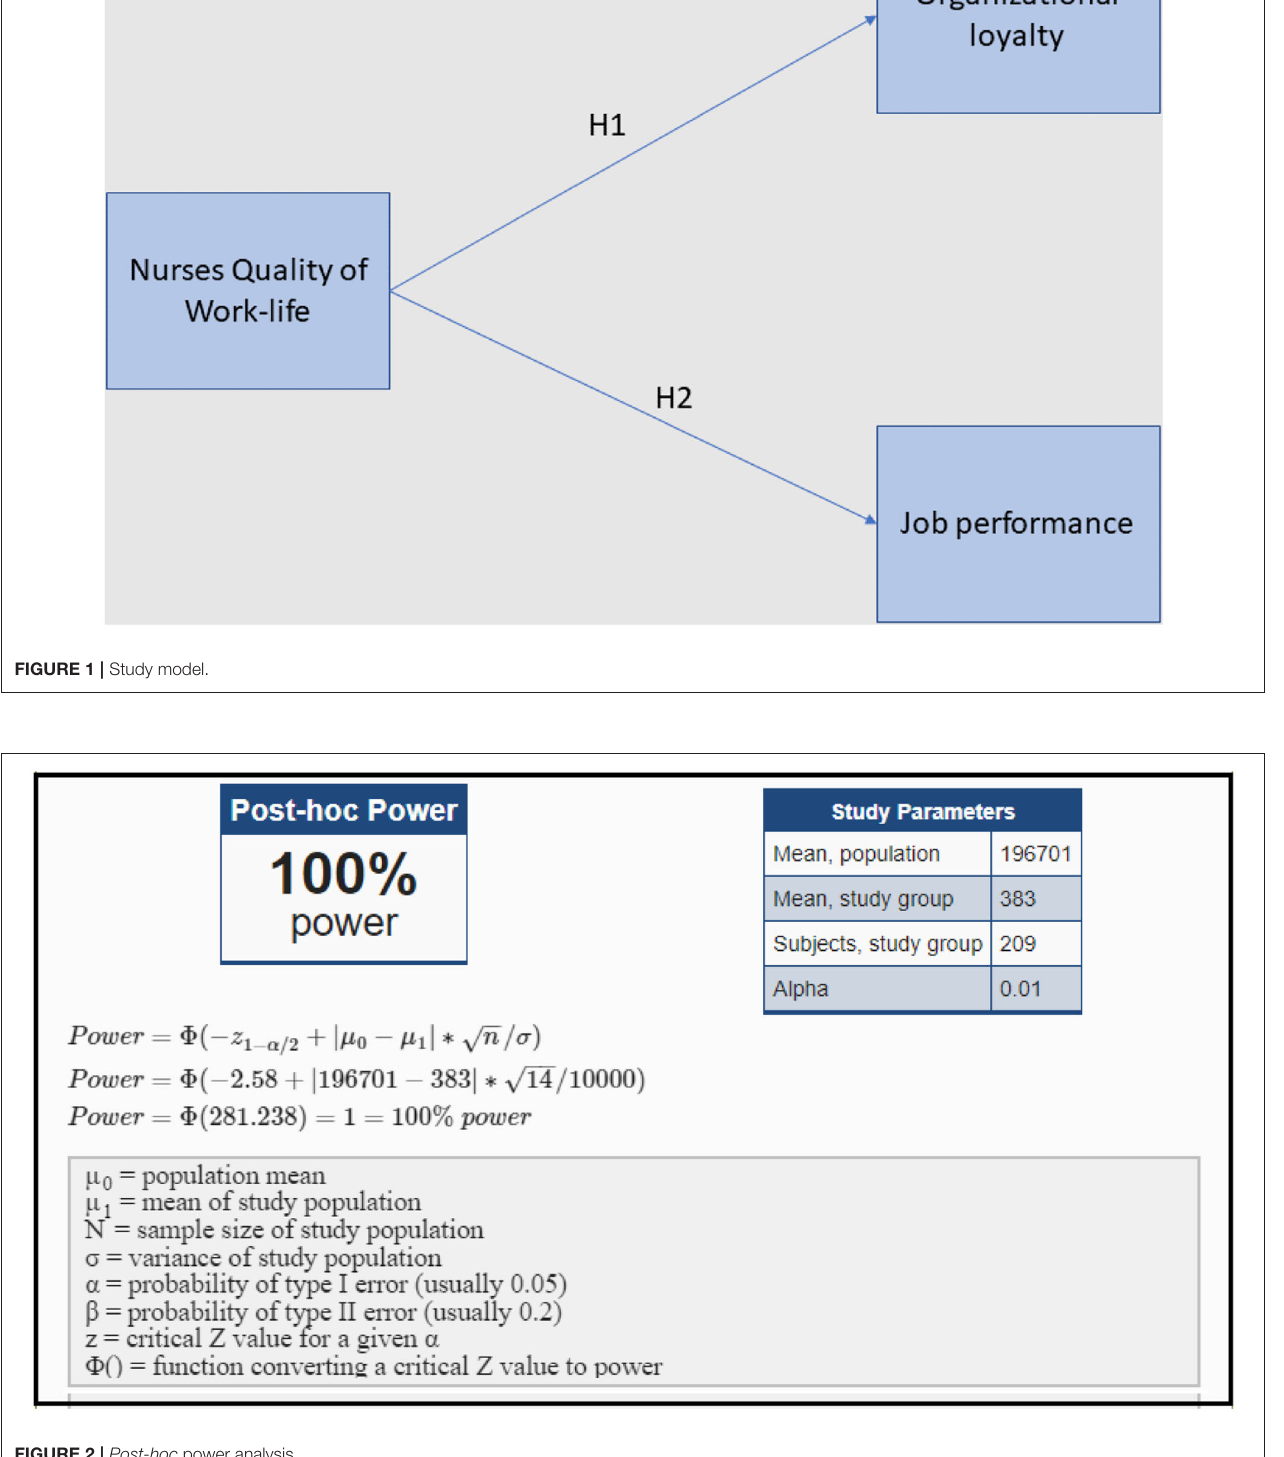
FIGURE 2 | Post-hoc power